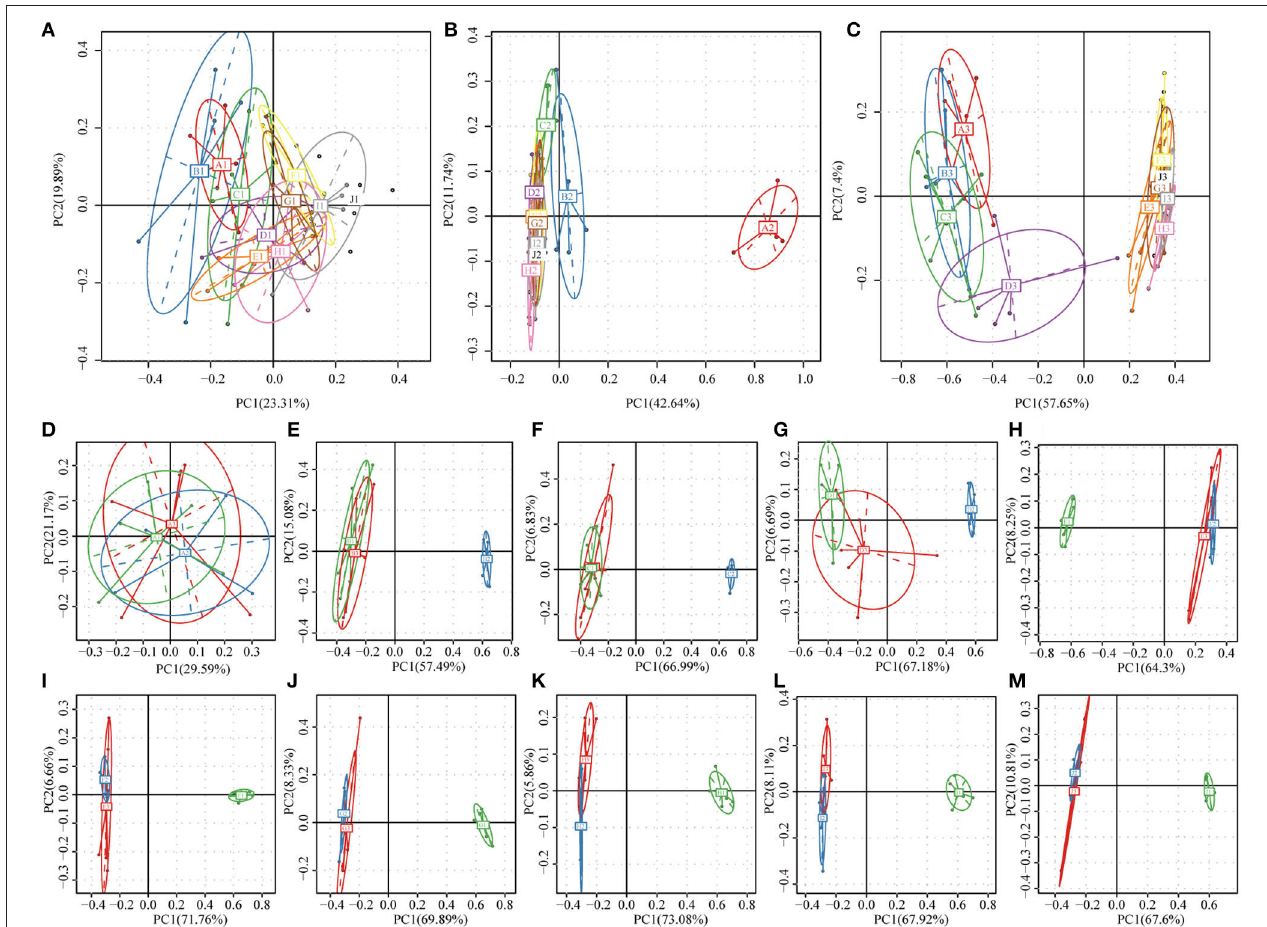
FIGURE 4 | Principal component analysis (PCA) of bacterial community composition based on relative abundances of 16S rRNA from 159 samples. (A–C) Show the NC, HFD, and BB-12 group, respectively; letters A–I in the figures represent the fecal samples from 0 to 8 weeks and J represents colonic content samples. (D–L) represent the fecal samples at 0–8 weeks, respectively and (M) represented the colonic contents samples; the numbers 1–3 in (D–M) represent the NC, HFD, and BB-12 group,